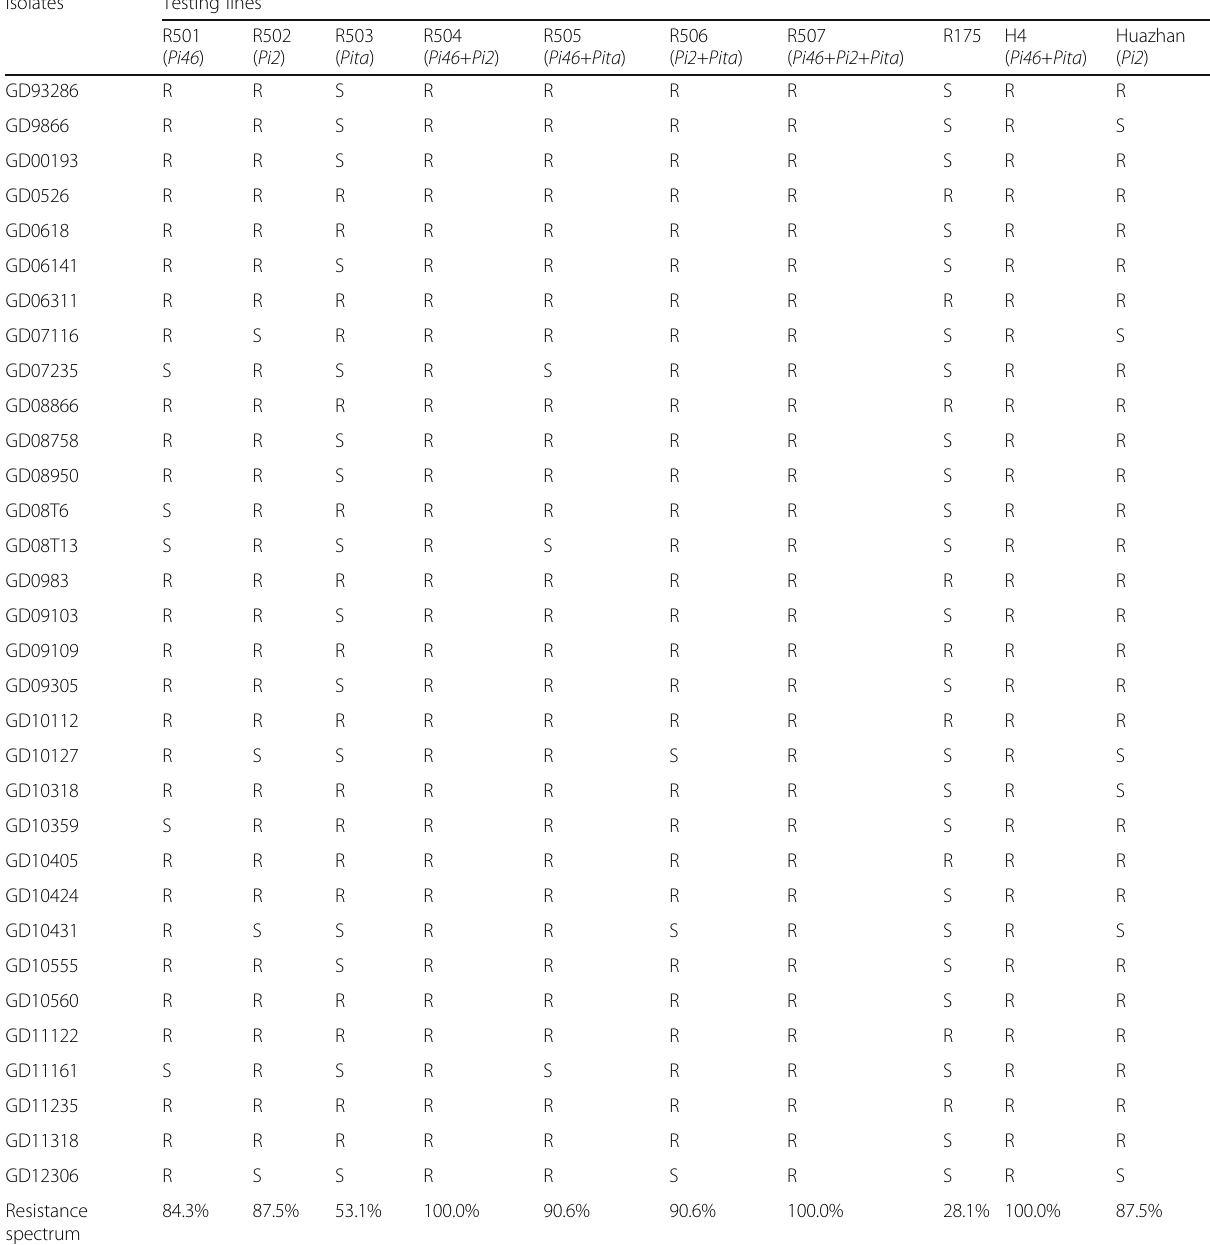
Table 4 Resistance reactions of tested lines to 32 M. oryzae isolates Isolates Testing